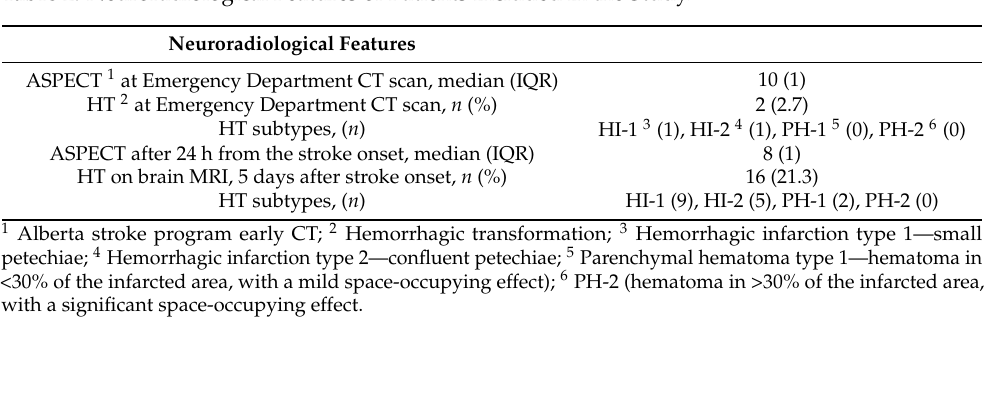
Table 2. Neuroradiological Features of Patients Included in the